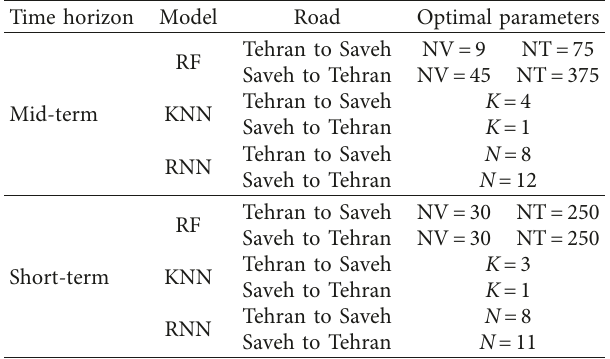
Table 3: Selected optimal values for models parameters.